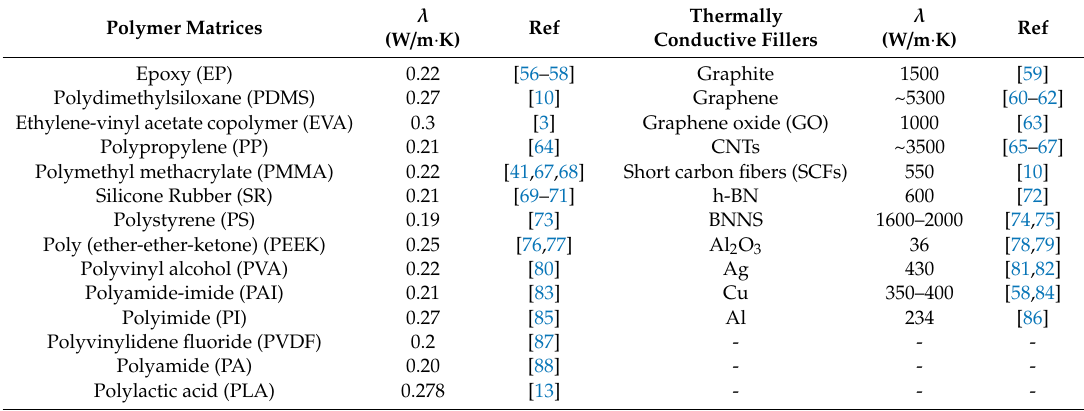
Table 1. λ of commonly used polymer matrices and fillers at room